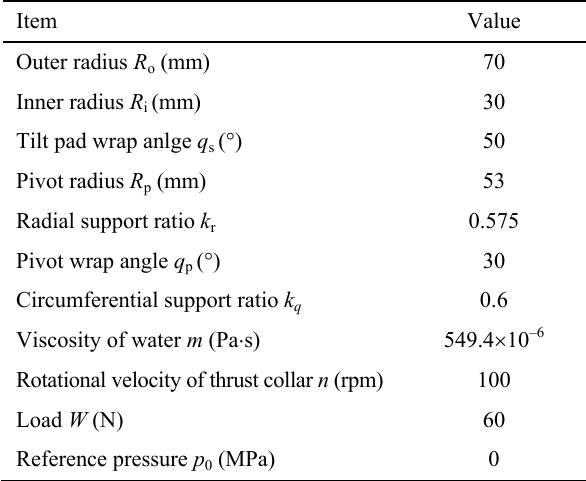
Table 2 Geometric parameters of the tilt pad thrust bearing and operation